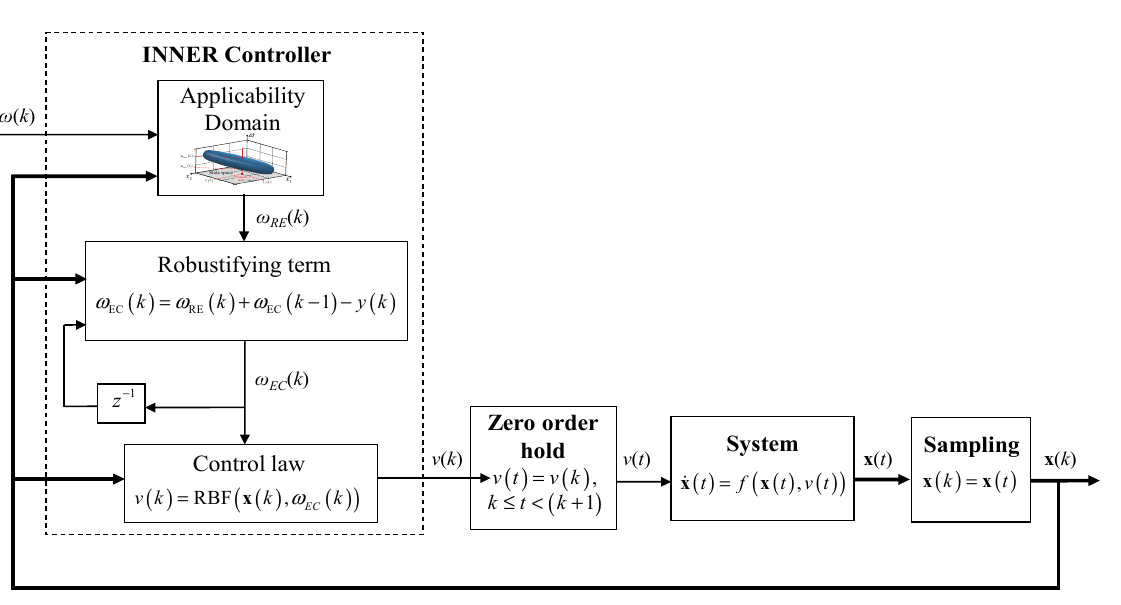
Figure 4. Closed loop with the RBF INNER control scheme, taking into account the applicability domain and the robustifying term.